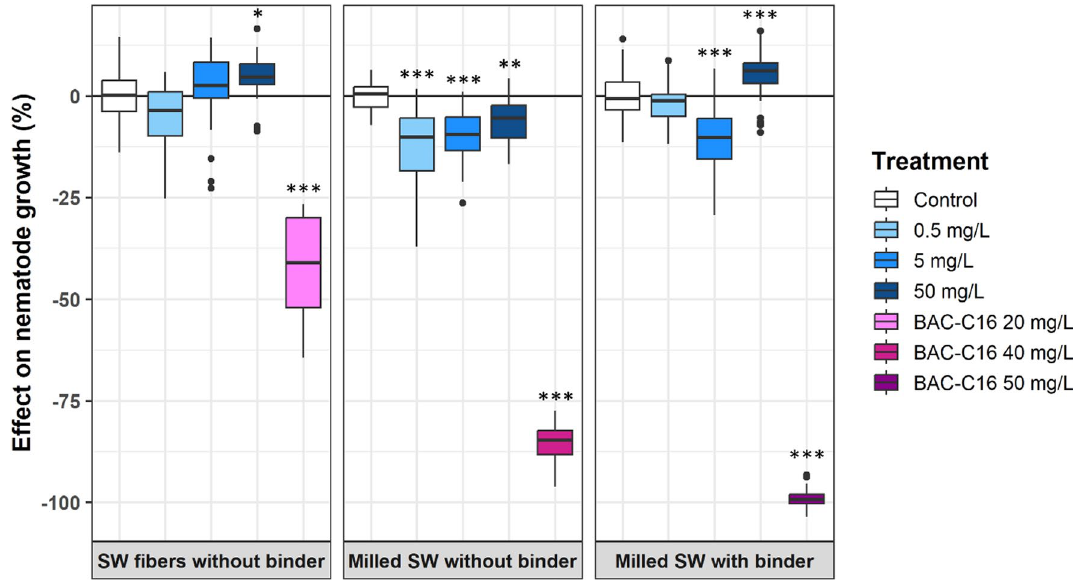
Fig. 7 Chronic effects (96 h) on growth of C. elegans for the negative control (white), the eluates of three concentrations (0.5, 5 and 50 mg/L) of each of the three test materials (blue colors) and the positive control (BAC‑C16; violet colors) as boxplots. Boxes depict the lower and upper quartile as well as the median; whiskers show the standard deviation of mean of n > 10 replicates and dots represent outliers. Effects were calculated in comparison to the mean growth in the negative control and positive effect values show nematode growth stimulation, while negative values show growth inhibition. Asterisks denote significant differences between the treatments and the negative control (Dunn’s test: *: p < 0.05, **: p < 0.01, ***: p < 0.001)